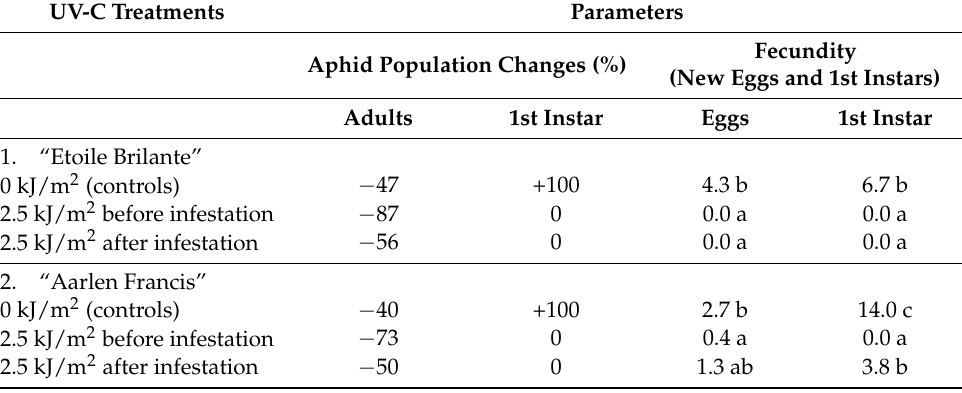
Table 1. Rose leaf bioassays (RLB) of vars. “Etoile Brilante” and “Arlen Francis” plants. The effects of 2.5 kJ/m 2 UV-C irradiation before or after infestation on the adult and 1st instar Macrosiphum rosae population changes (% from initial values) and fecundity (number of new eggs and 1st instar aphids) were recorded. Untreated leaves were used as controls. Each leaflet was initially infested with 5 adult aphids. Numbers are means separated with different letters according to the Duncan’s multiple range test at